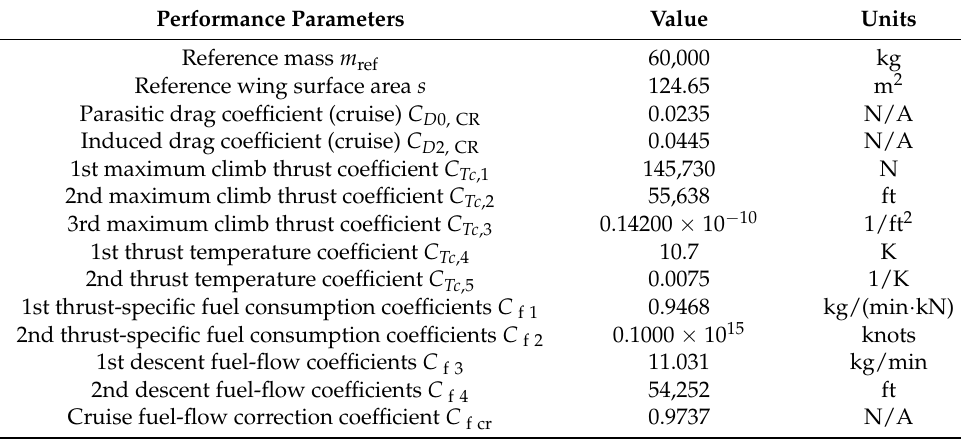
Table A1. Performance operational data of aircraft A1.